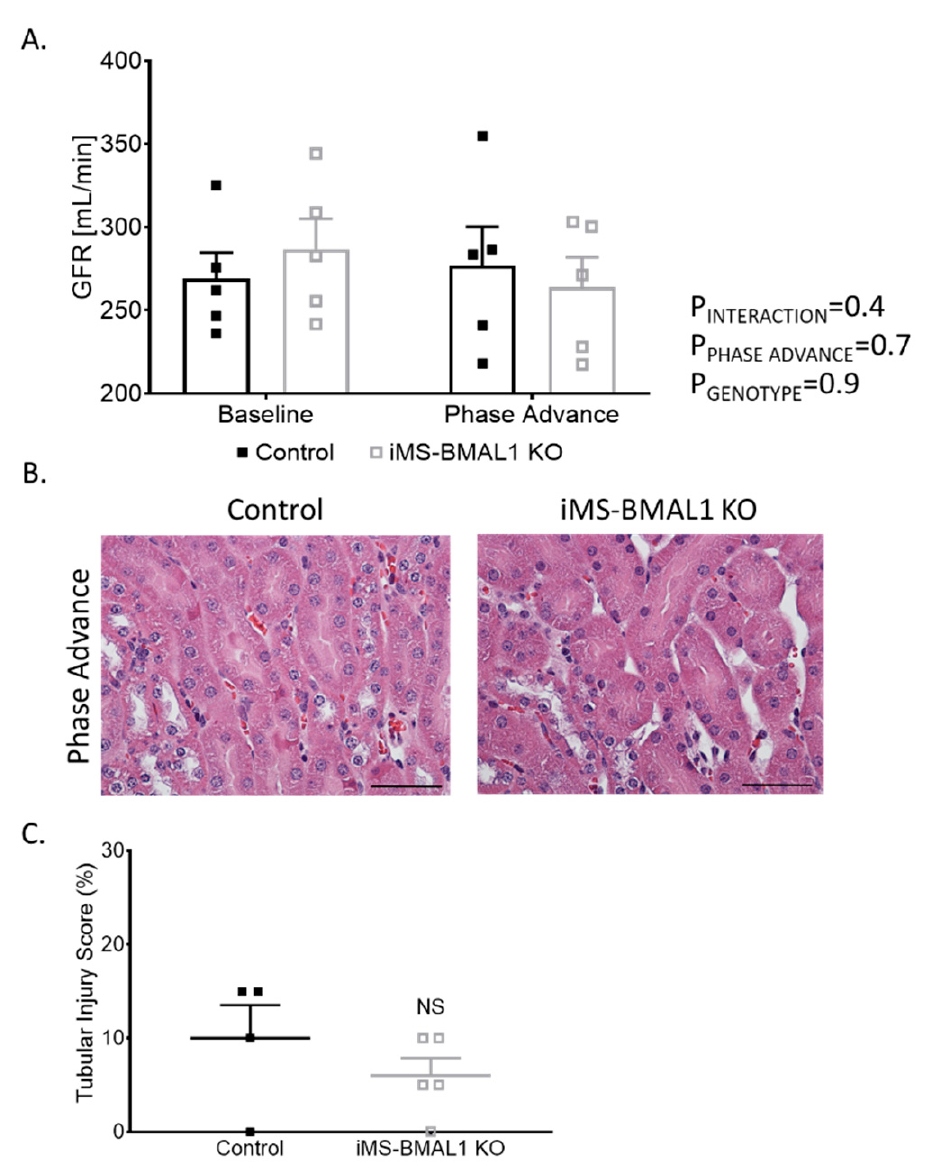
Figure 4. Clock disruption in skeletal muscle does not affect renal function or cause tubular injury. ( A ) Glomerular filtration rate measured via a subcutaneous monitor before and after phase advance in control and iMS-BMAL1 KO mice. n = 5. ( B ) Representative images of kidney sections stained with hematoxylin and eosin from control and iMS-BMAL1 KO mice following phase advance. Cortical region is shown. Scale bar represents 0.05 mm. ( C ) Percentage of tubules that exhibit signs of injury seen in stained kidney sections from both groups of mice. n = 4–5. All data are presented as mean ± SEM. Two-way ANOVA was used to compare groups’ glomerular filtration rate data. Student’s t -test was used to compare groups from tubular injury assessment data. GFR = glomerular filtration rate; NS = not